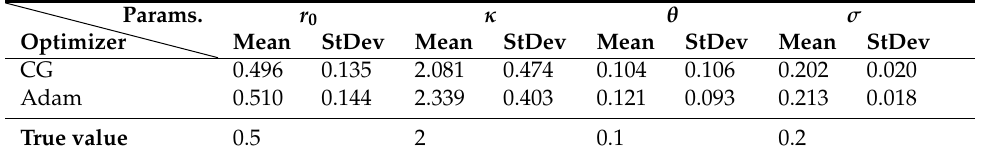
Table 1. Single curve calibration results with mean and standard deviations (StDev) of the learned parameters (params.) of 1000 simulated log-bond prices as well as the true Vasiˇcek parameters.